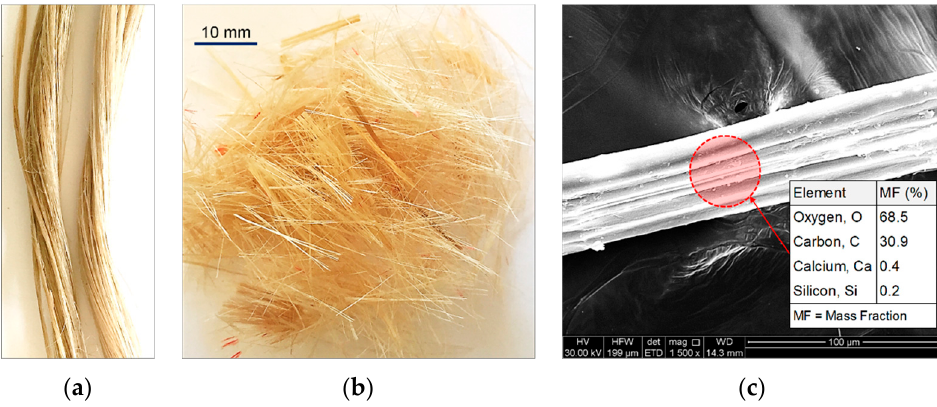
Figure 1. JF at different magnification ratios: ( a ) Raw fibers (no magnification); ( b ) Processed fibers (no magnification); and ( c ) Processed fibers (1500× magnification).